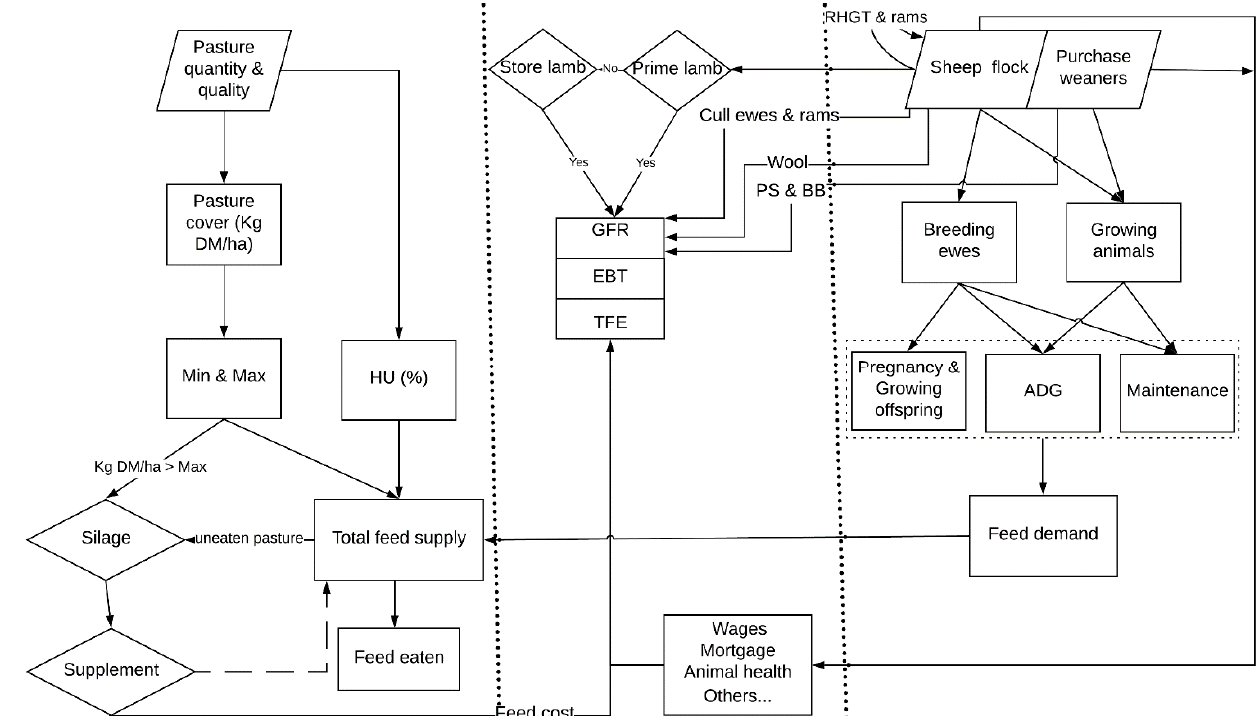
Figure 1. Model inputs (pasture quantity and quality parameters, beef cattle herd, and sheep flock), total utilizable feed supply, silage, and feed demand from the beef cattle and sheep activities. The outputs of the model include prime (sold to meat processing plant) and store lambs (sold to other farmers for finishing), replacement hoggets (between 4 to 16 months of age, mated at 8 months of age), cull ewes and rams, wool, prime steers (PS) and bull beef (BB), gross farm revenue (GFR), total farm expenditure (TFE), and farm earnings before tax (EBT). The rectangular boxes represent the process of the system, while activities which need decision are represented by the diamond boxes and the vertical dotted lines are drawn to separate the three main modules of the system. Min and Max: minimum and maximum pasture mass (kg DM/ha); HU: herbage utilization (%); ADG: Average daily gain; RHGT: replacement